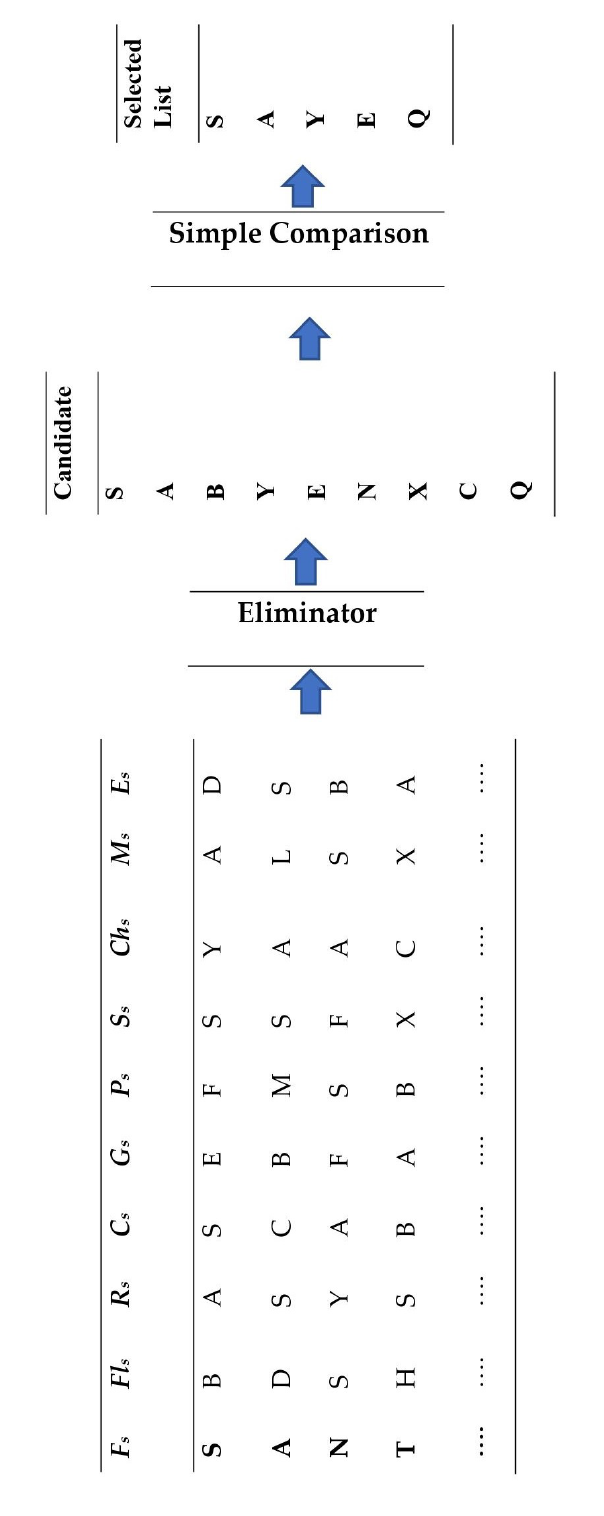
Figure 2. Skyline